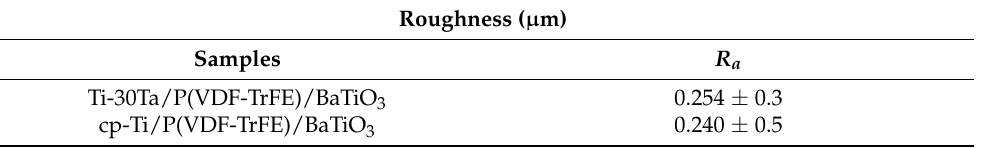
Table 10. Roughness of the P(VDF-TrFE)/BaTiO 3 deposited on cp-Ti and Ti-30Ta substrates.